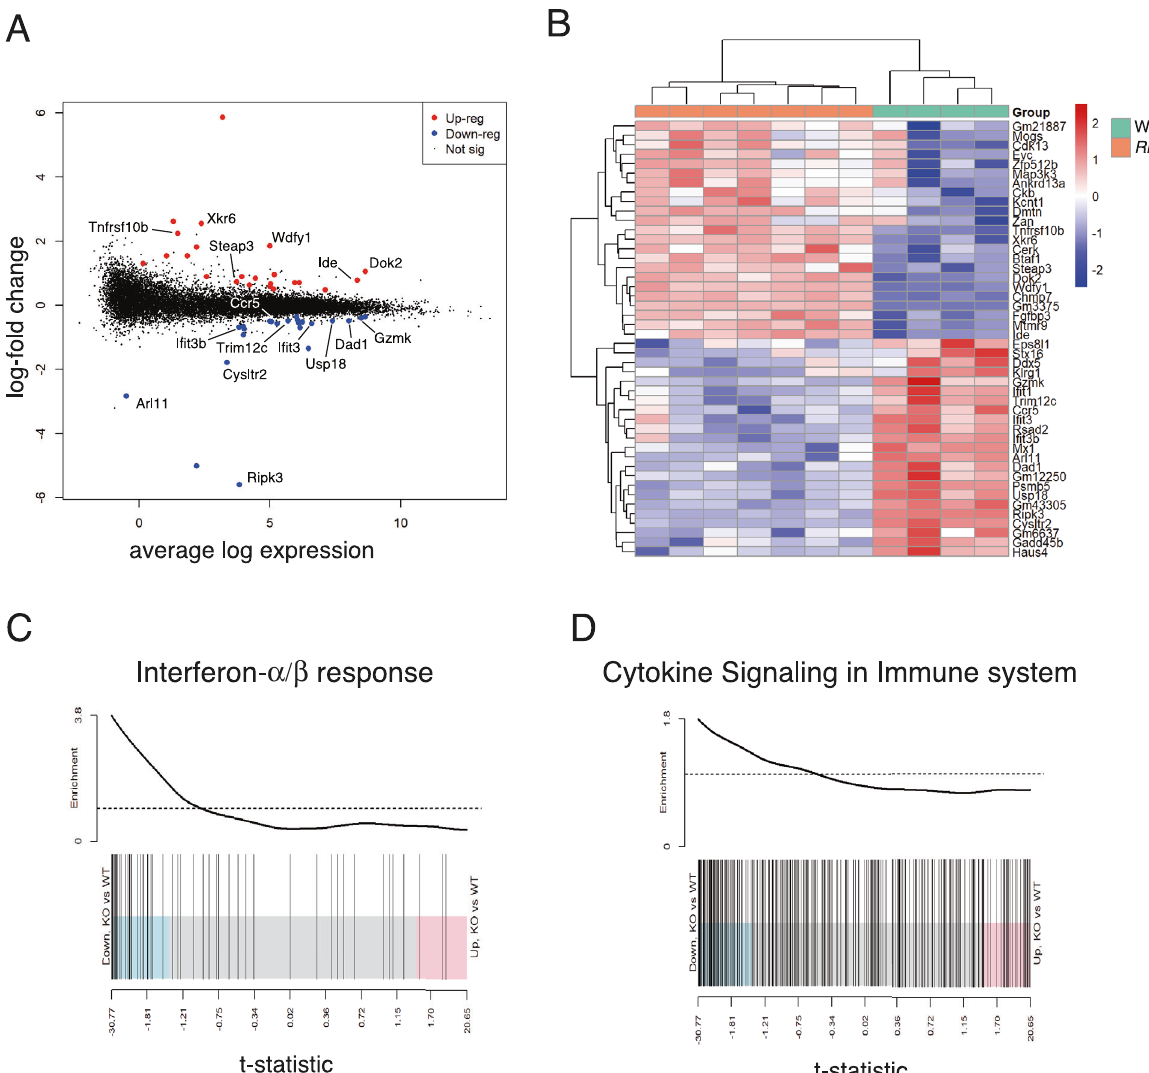
Fig. 5 RNA sequencing reveals a depressed interferon signature in RIPK3-de fi cient mice infected with LCMV docile. A MD plot showing the genes downregulated (blue) or upregulated (red) in Ripk3 − / − LCMV-speci fi c CD8 + T cells versus WT. Genes of interest are indicated. B Heatmap of 46 signi fi cantly differentially expressed genes ( p < 0.05) in LCMV-speci fi c CD8 + T cells from WT mice compared to Ripk3 − / − mice (mean of n = 4 WT, n = 7 Ripk3 − / − per group, differential expression assessed u sing a robust empirical bayes procedure, FDR controlled below 0.10 using Benjamini and Hochburg method). Colour code indicates Z-score. C Barcode plot analyses of Hallmark gene set analysis for genes involved in interferon- α / β response in LCMV-speci fi c CD8 + T cells from Ripk3 − / − mice compared to WT mice (gene enrichment test using ROAST method). D Barcode plot analyses of curated gene set of genes involved in interferon- α / β response in LCMV-speci fi c CD8 + T cells from Ripk3 − / − mice compared to WT mice (gene enrichment test using ROAST method). All data in was obtained from fl ow-cytometry sorted T cells, isolated from animals sacri fi ced 14 days post infection with LCMV